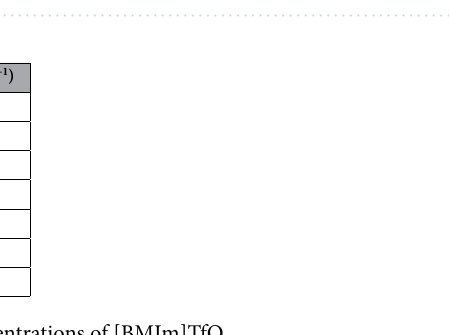
Figure 6. ( a ) Arrhenius and ( b ) Transition-state plots for carbon steel corrosion in 3.5% NaCl without and with different concentrations of [BMIm]TfO.